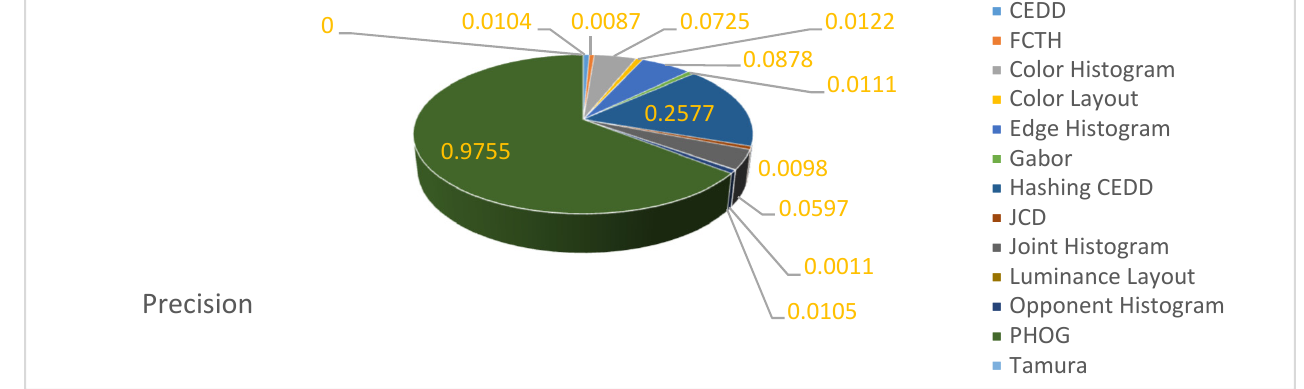
Figure 22. Comparing all descriptors from a viewpoint which relates all of the descriptors to the filters. Here, another way to rank the descriptors according to image retrieving performance using the average precision@K is shown. Out of the number of images, k is set to 10,000. Figure 23 shows the precision@10,000 for all the used descriptors. As can be seen, on average, the PHOG has the best precsion@10,000 followed by Hashing CEDD, where they locate the images early with a relatively high score. Other descriptors vary in their measures based on the image position in the retrieval process. However, it is recommended to consider each descriptor separately along with each type of image to be retrieved.